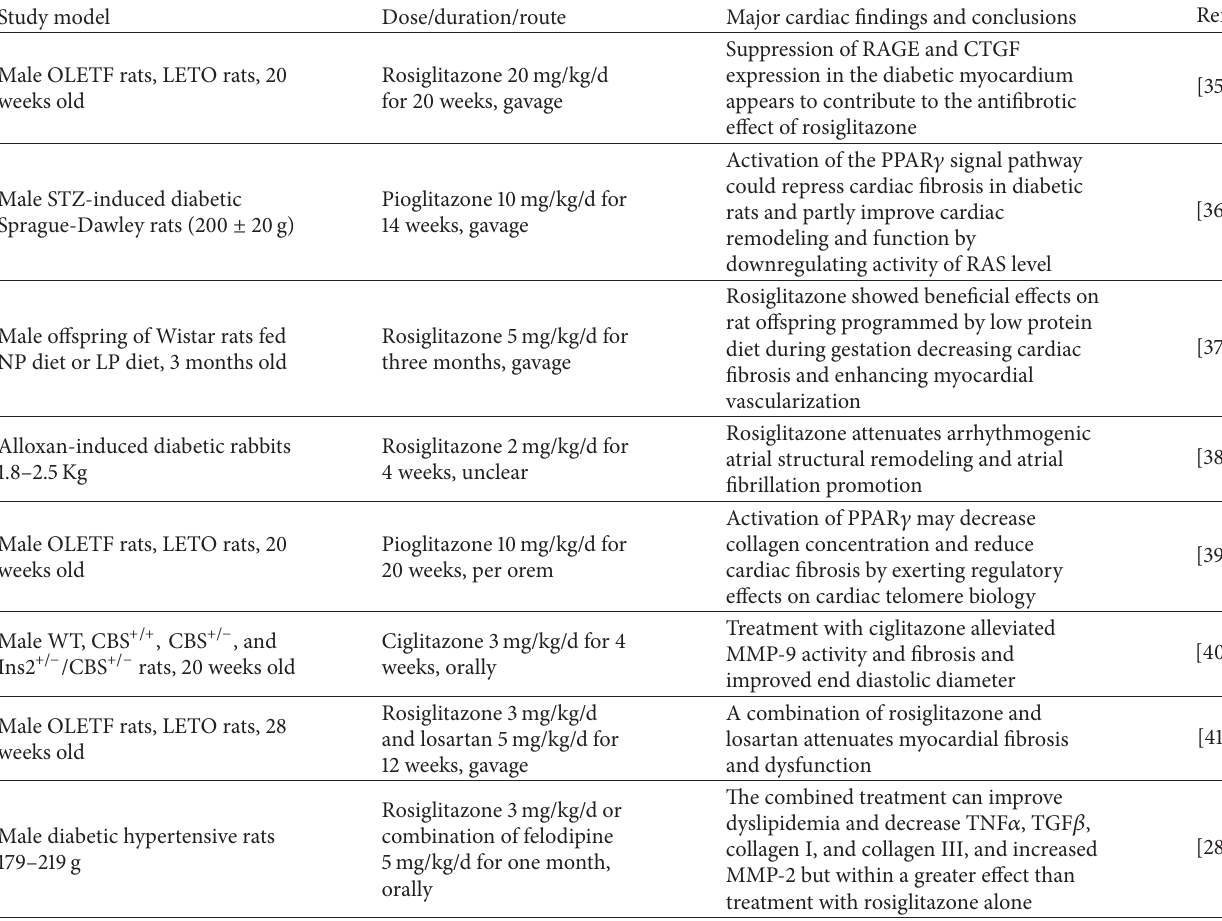
Table 2: Effects of PPAR 𝛾 ligands on diabetic related cardiac